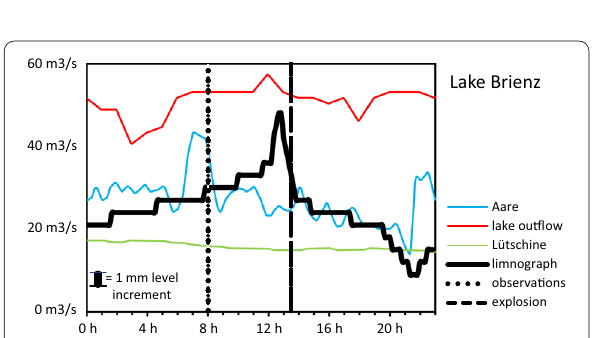
Fig. 2 The digital record of the Ringgenberg limnograph near the lake outflow, the digital increment is 1 mm, and the records of the three river discharges on April 24th 1996, the time unit is GMT. Large waves have been noticed by two eyewitnesses at 8 h but are not registered by the limnograph near the lake outflow. Indicated is also a 300 kg Telsit explosion near Iseltwald, 6 km away from the Aare delta and 1 h after a striking deflection of the limnograph. The Telsit time signal is probably